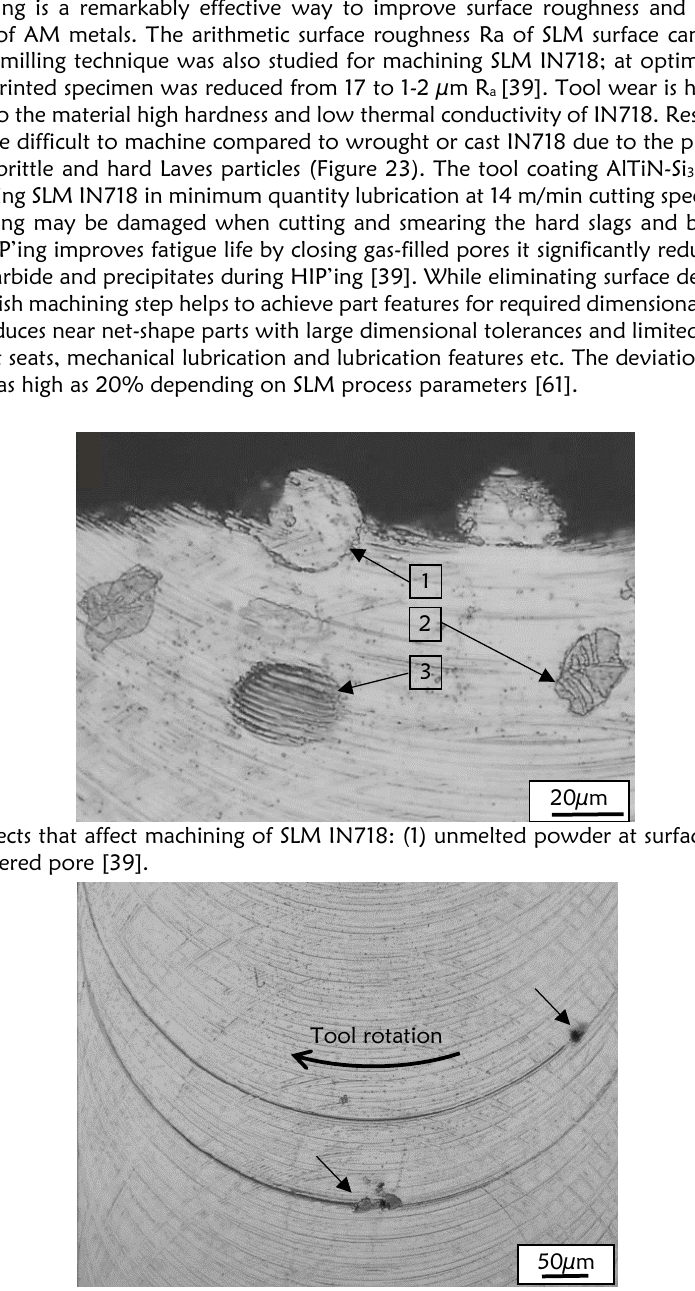
Figure 24. Smearing of sheared brittle Laves particles (at arrows) on a milling surface